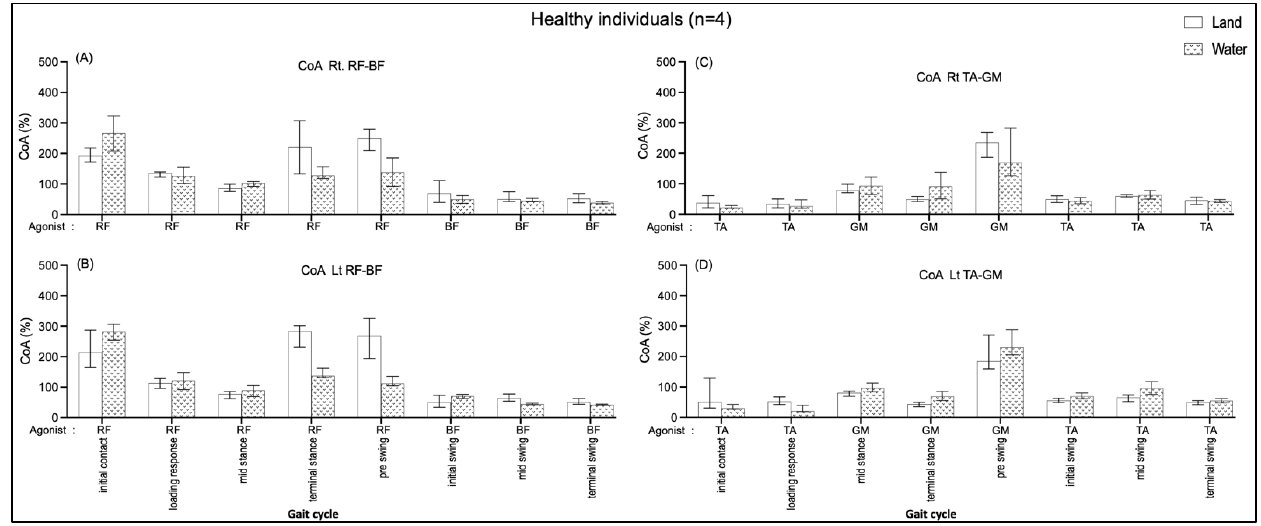
Figure 6. Co-activation index (CoA) of right RF-BF ( A ), left RF-BF ( B ), right TA-GM ( C ), and left TA-GM ( D ) during walking in water and on land in healthy individuals.